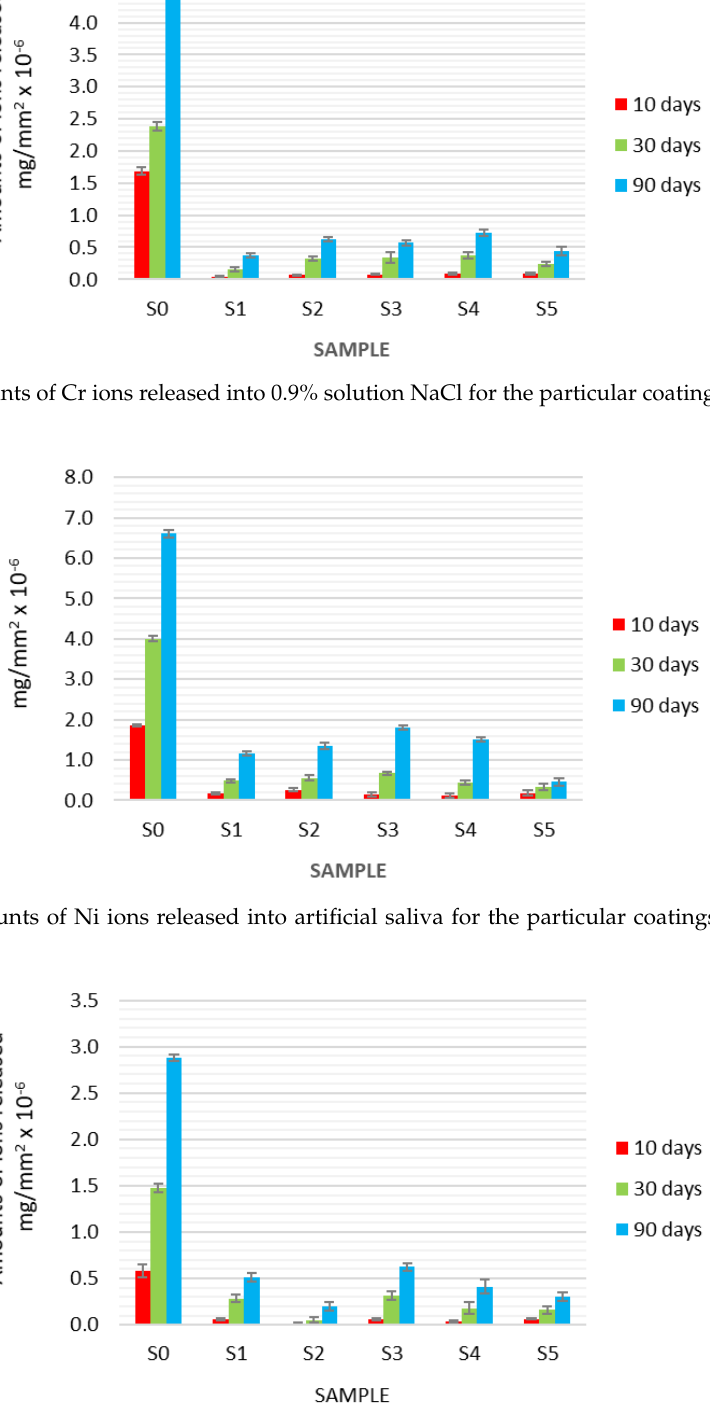
Figure 8. Amounts of Cr ions released into 0 artificial saliva for the particular coatings after 10, 30, and 90 days.